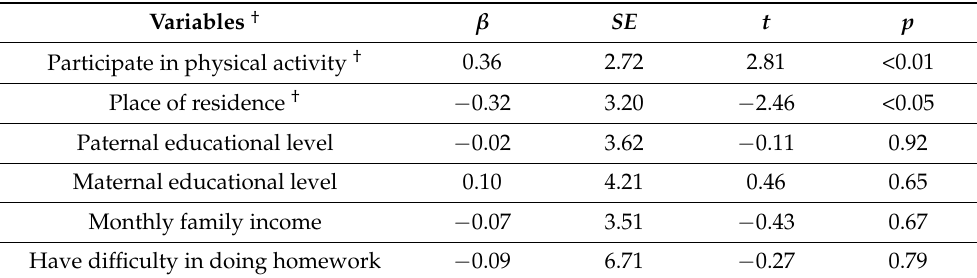
Table 4. Multivariate linear regression analysis of influencing factors on self-concept in dyslexic group ( n = 50).